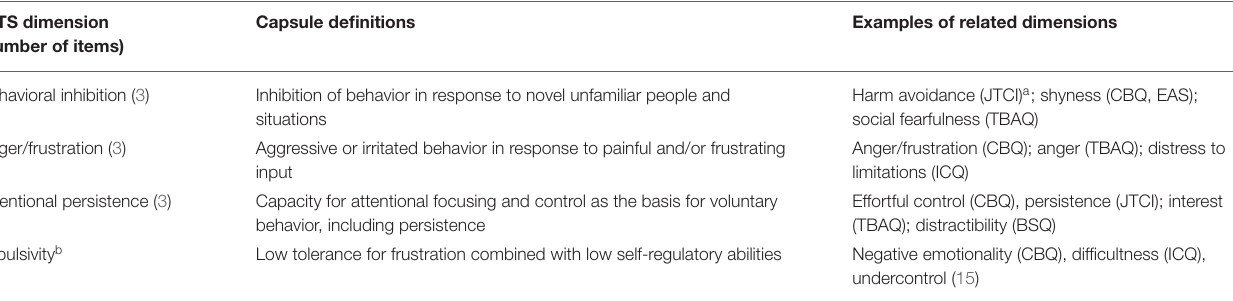
TABLE 2 | Summary and capsule definitions of temperament dimensions included in the